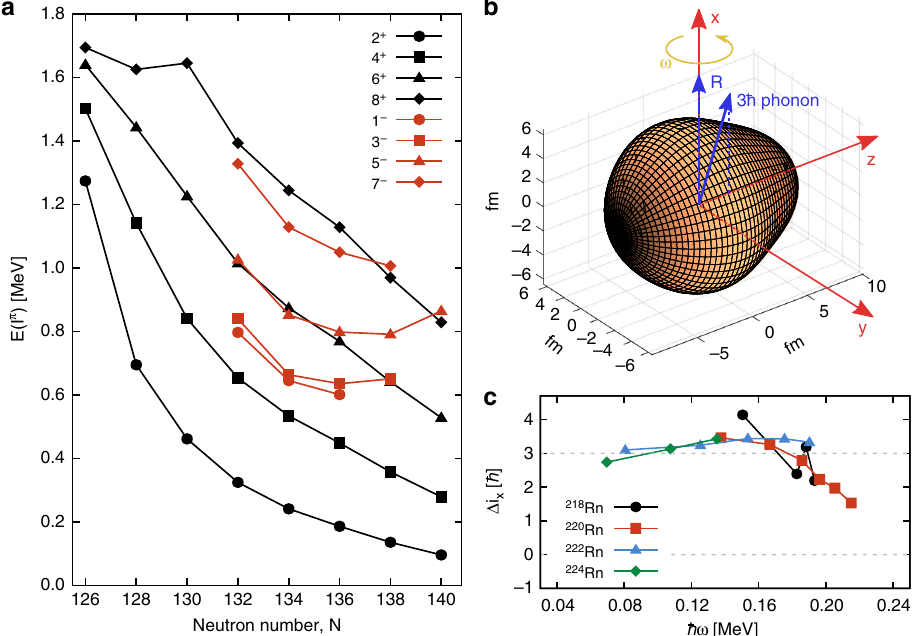
Fig. 4 Systematic behaviour of radon isotopes. a Systematics of the energies for different spins of low-lying positive-parity (black) and negative-parity states (red) in radon isotopes; b cartoon illustrating how the octupole phonon vector aligns with the rotation ( R ) vector (which is orthogonal to the rotating body ’ s symmetry axis) so that I = R + 3 (cid:1) h and Δ i x ¼ 3 (cid:1) h ; c difference in aligned spin for negative- and positive-parity states in 218-224 Rn (re-analysed for 218- ¼ 0 is the expected value for static-octupole 222 Rn that have been presented earlier 23 ). The dashed line at Δ i x